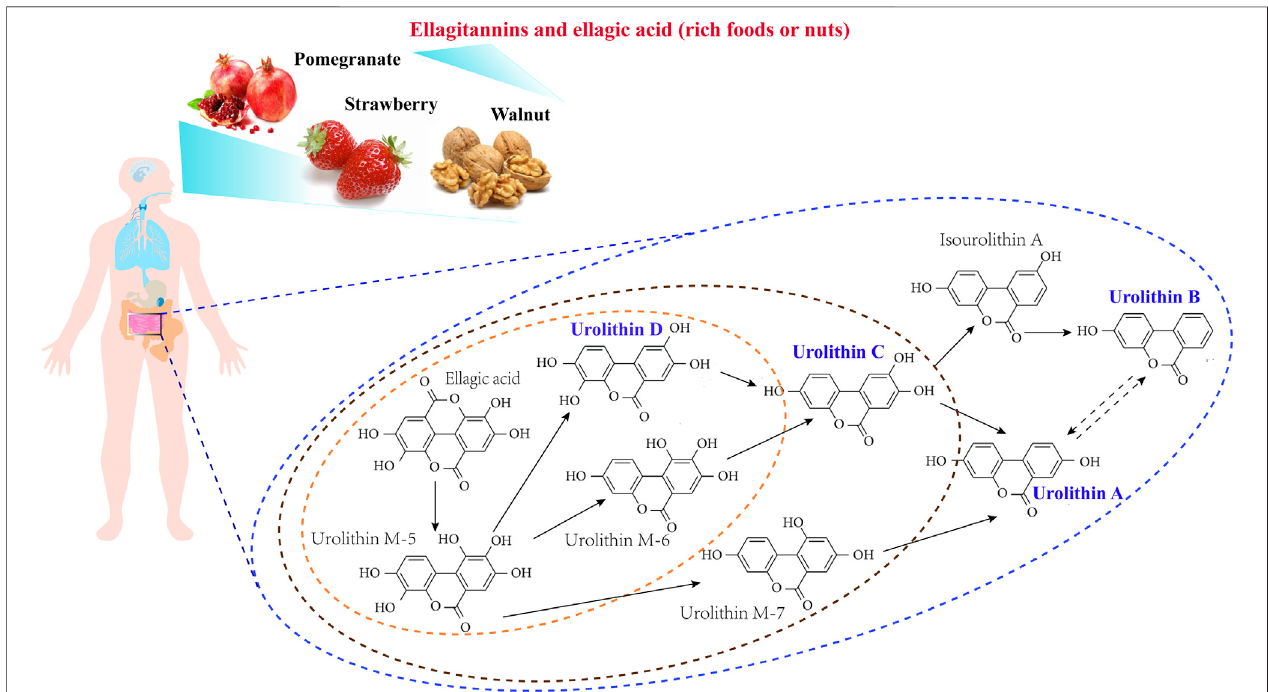
FIGURE 1 | A schematic view of ellagitannins and ellagic acid gut microbiota metabolism pathway.